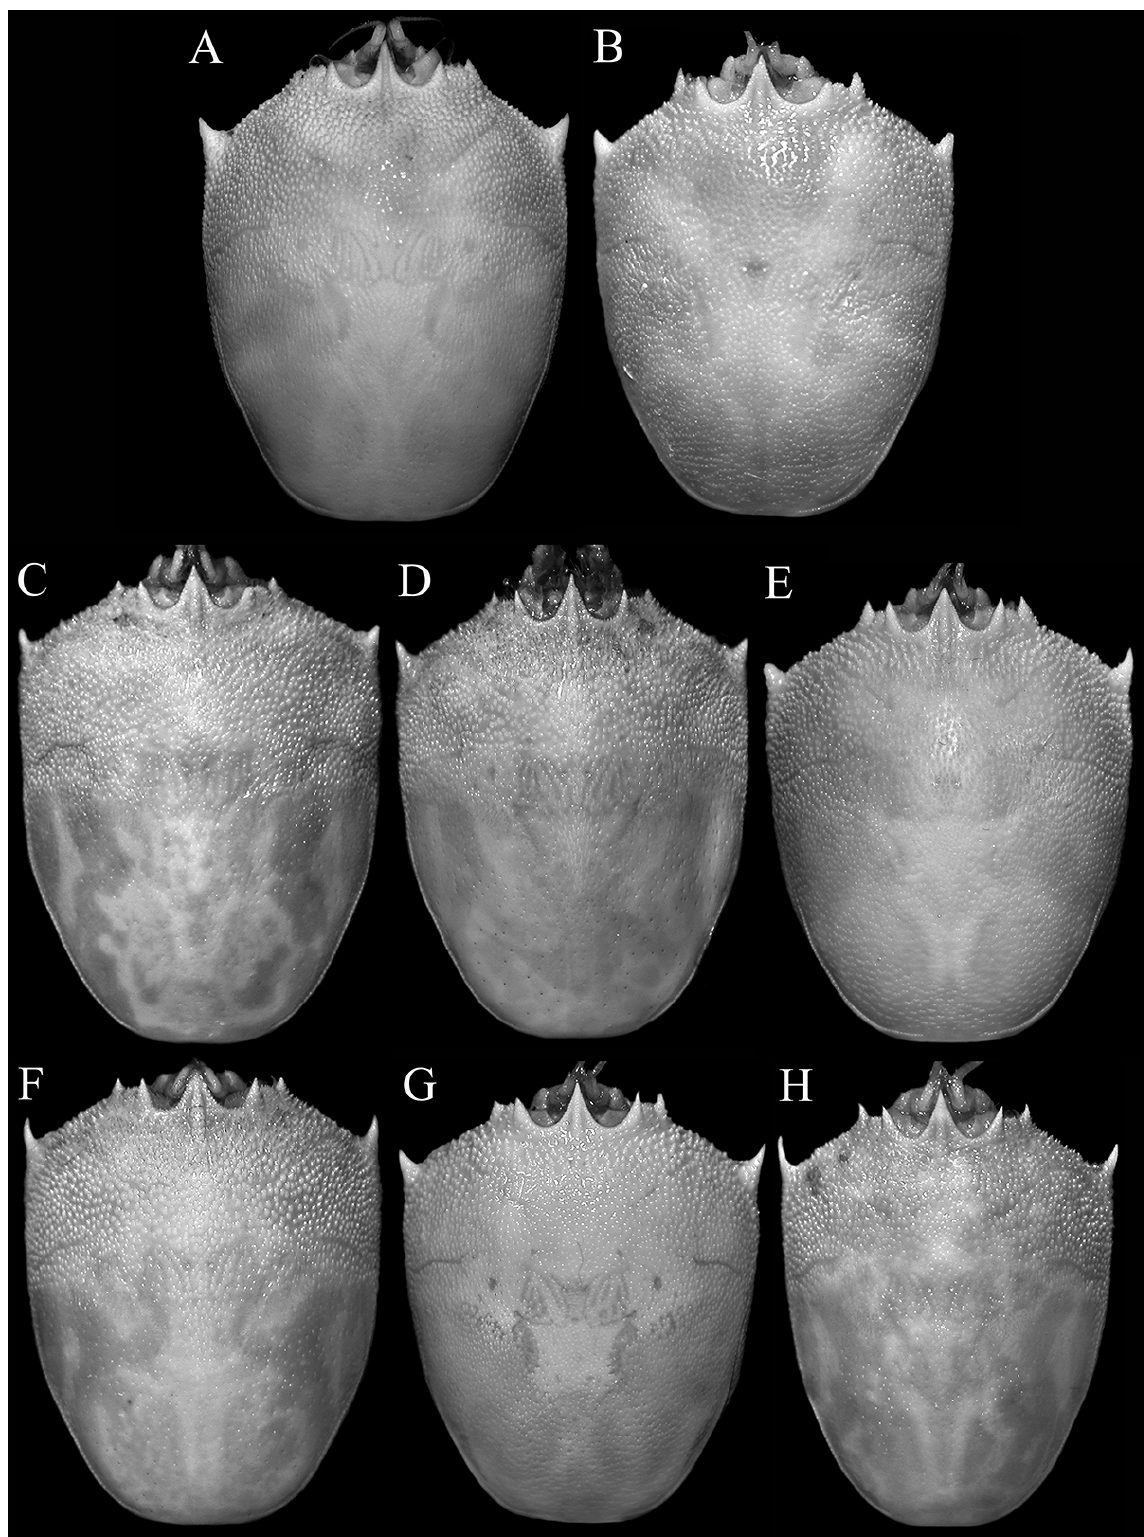
Figure 3. Dorsal view of carapace. A, Umalia trirufomaculata , holotype male (20.4 x 26.3 mm) (WAM 348-60), Western Australia; B, U. trirufomaculata , male (11.8 x 15.6 mm) (ZSI), Andamans; C, U. misakiensis , male (26.0 x 34.2 mm) (ZRC 2001.0637), Philippines; D, U. misakiensis , male (23.9 x 31.2 mm) (ZRC 2001.0637), Philippines; E, U. misakiensis , male (23.4 x 28.9 mm) (ZRC 2018.1378), Philippines; F, U. misakiensis , male (22.6 x 27.7 mm) (ZRC 2001.0637), Philippines; G, U. misakiensis , male (18.0 x 21.8 mm) (ZRC 2001.0637), Philippines; H, U. misakiensis , male (16.0 x 21.8 mm) (ZRC 2001.0637),